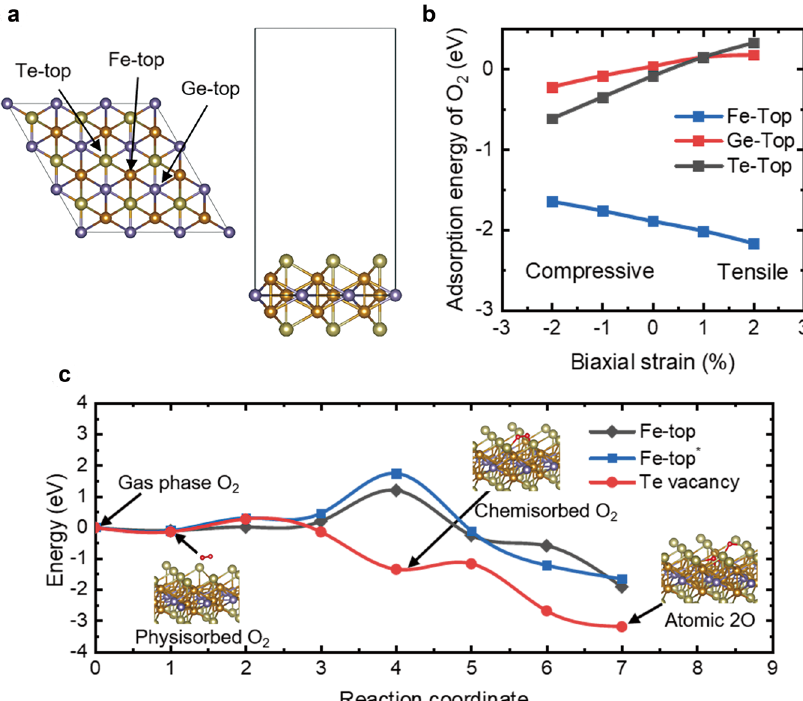
Fig. 5 Modeling and calculation of the strain and Te vacancy effects on oxygen adsorption on monolayer Fe 3 GeTe 2 . Supplementary Fig. 2 shows the detailed geometry of each structure after relaxation. a Top (left panel) and side (right panel) views of the atomistic con fi guration of the supercell of monolayer Fe 3 GeTe 2 . b Site-dependent dissociative adsorption energy of O 2 on Fe 3 GeTe 2 as a function of the biaxial strain. c Oxygen dissociative adsorption kinetics on the pristine Fe 3 GeTe 2 (black and blue curves) and a defective Fe 3 GeTe 2 with Te vacancy (i.e., V Te , red curve). Insets display the relaxed con fi gurations of the physisorbed O 2 , chemisorbed O 2 , and dissociated 2 O atoms on the defective Fe 3 GeTe 2 with V Te , respectively. Two different con fi gurations of atomic 2 O near Fe-top sites (Fe-top and Fe-top * in the legend of ( c )) are chosen as the possible fi nal states on the pristine Fe 3 GeTe 2 , where Fe-top * indicates the con fi guration of higher